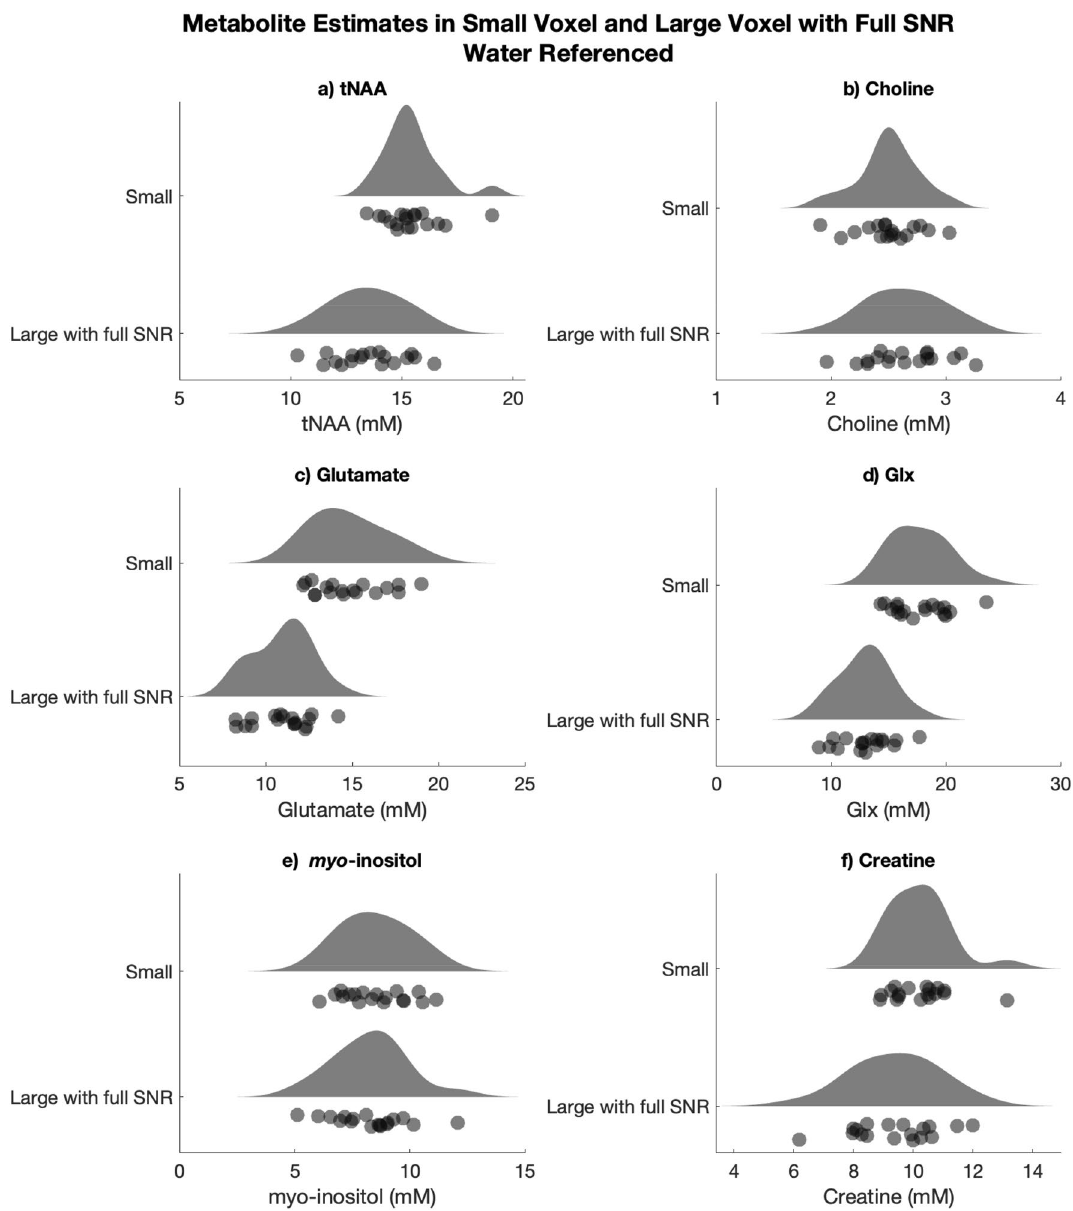
Figure 3. Raincloud plots of the milli-molal metabolite values of the small voxel (top) and full SNR large voxel (bottom). Raw data values are displayed below the probability distribution: a histogram smoothed with a kernel of 1 mm. Developed using 19 .